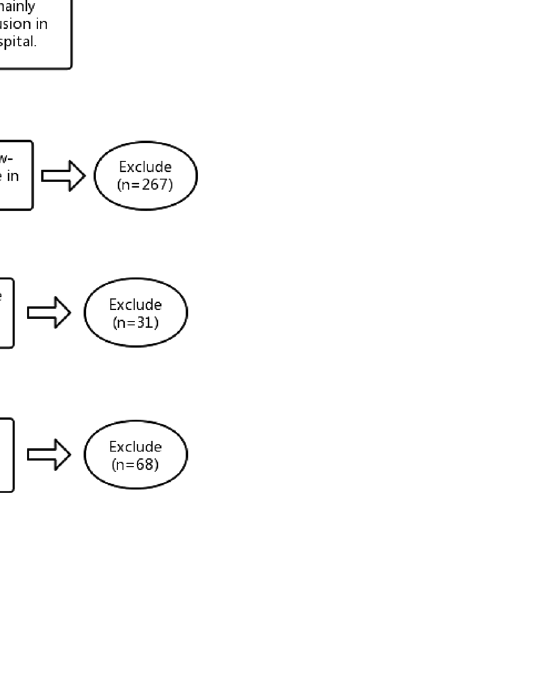
Figure 1. Patient screening flow